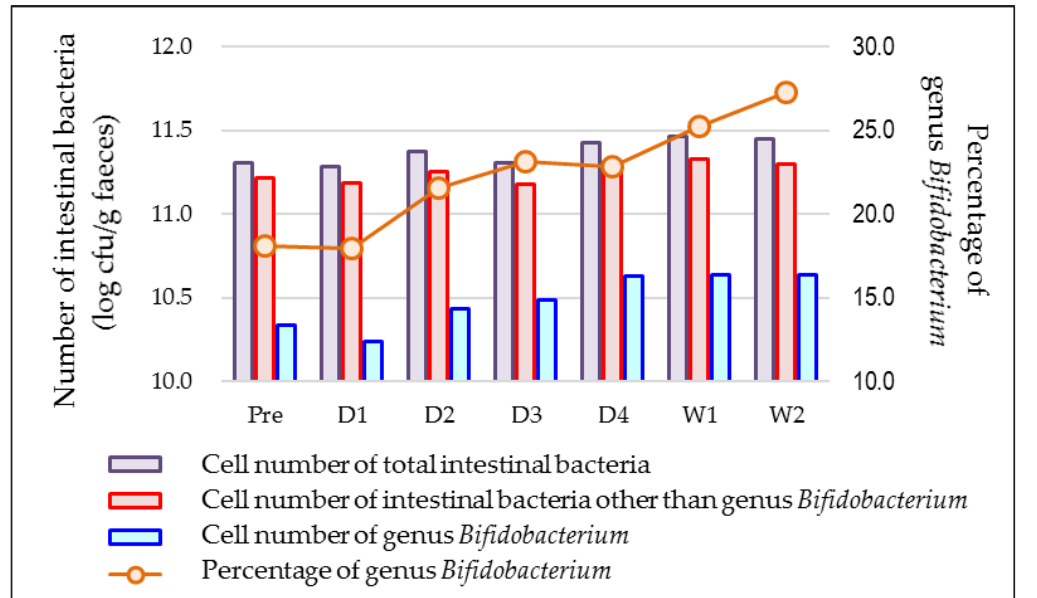
Figure A7. Cell numbers of intestinal bacteria and percentages of genus Bifidobacterium during lactulose ingestion. Pre means just before lactulose ingestion; D1 means 1 day after starting lactulose ingestion; D2 means 2 days after starting lactulose ingestion; D3 means 3 days after starting lactulose ingestion; D4 means 4 days after starting lactulose ingestion; W1 means 1 week after starting lactulose ingestion; and W2 means 2 weeks after starting lactulose ingestion. Values are expressed as the mean. CFU, colony-forming units.